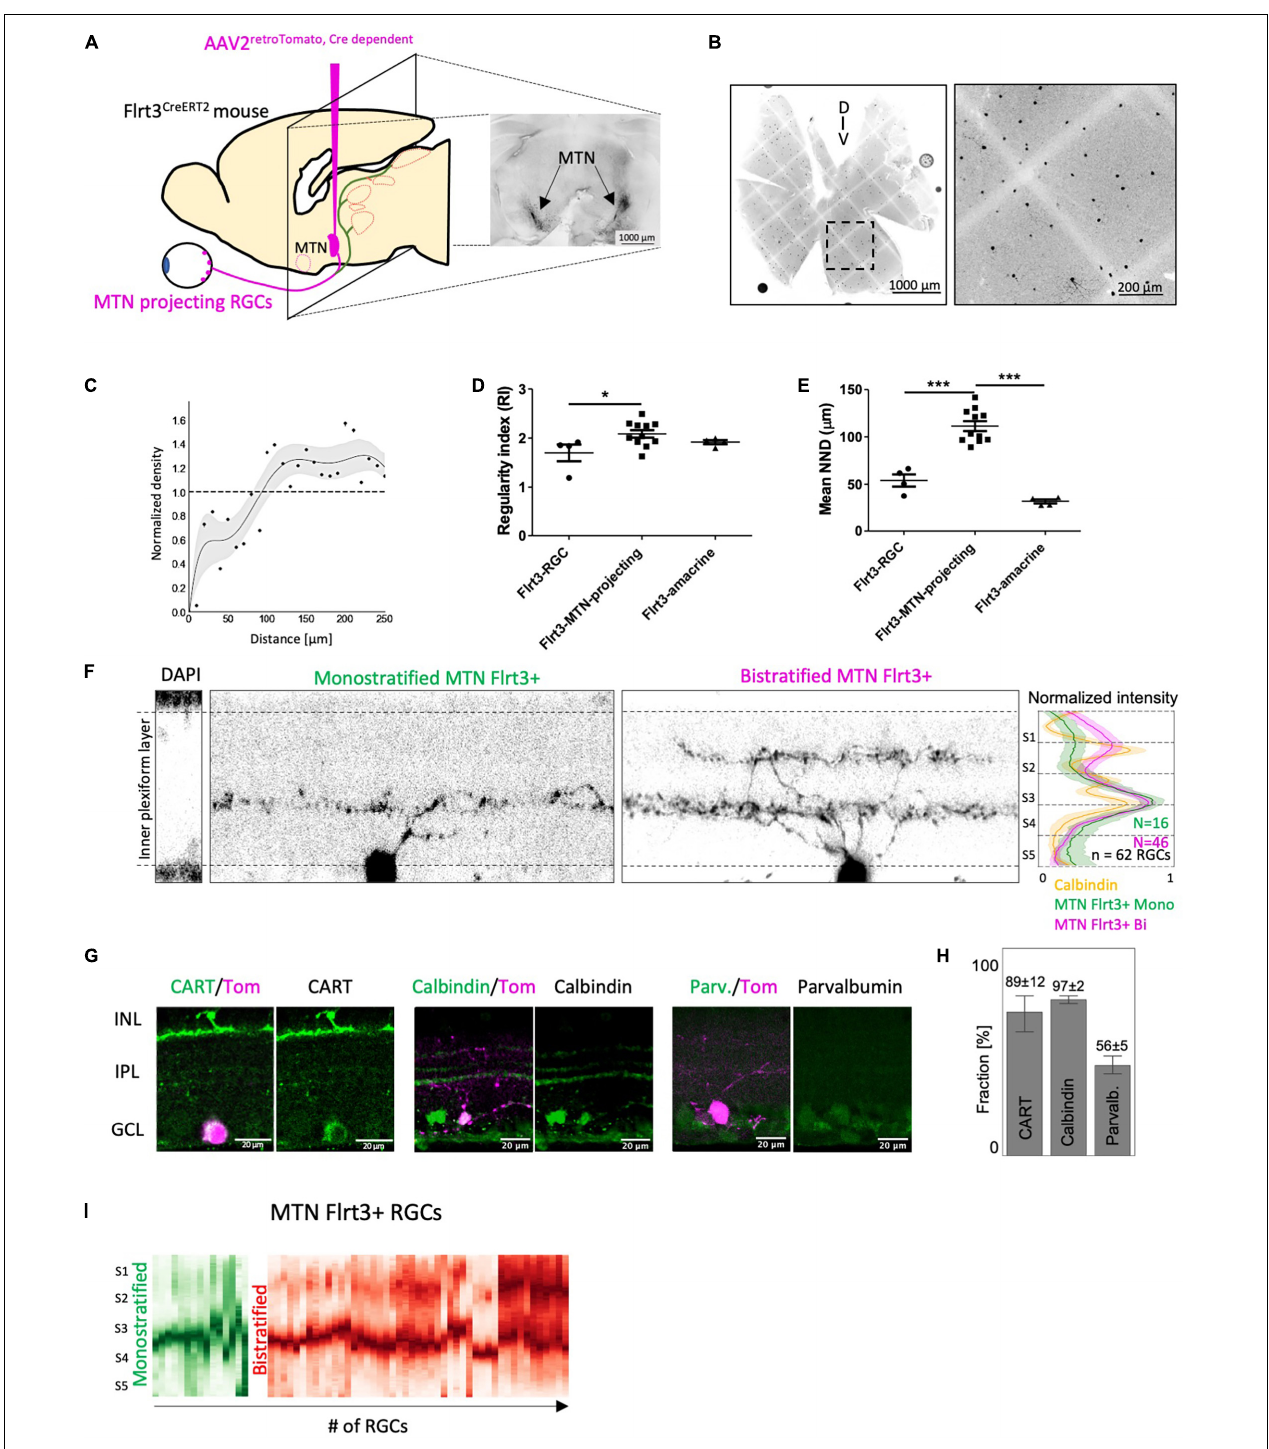
FIGURE 5 | MTN-projecting Flrt3-RGCs are a homogeneous downward ON-DSGC subpopulation. (A) Stereotaxic injection of AAV2 retro − cre − Tomato in the MTN of Flrt3-CreERT2 mice to identify Flrt3-RGCs projecting to the MTN. The image on the right shows a representative MTN-injection site after 3 weeks of viral expression. N = 4 mice. (B) Whole mount retina showing the distribution of MTN-projecting Flrt3-RGCs. (C) Normalized density profile of MTN-projecting Flrt3-RGCs. N = 50 ROIs from 11 retinas and 8 animals. (D) Regularity index plot for Flrt3-RGC, Flrt3-MTN-projecting-RGC and Flrt3-amacrine cells. N = 4–11 ROI from different retinas of 3–4 mice (as shown in (B) . One-way ANOVA Tukey’s Multiple Comparison Test, * P < 0.05. (E) Average nearest neighbor distance ( µ m), calculated from same ROIs as in (D) . One-way ANOVA Tukey’s Multiple Comparison Test, *** P < 0.001. (F) Orthogonal section through the IPL to visualize the stratification pattern